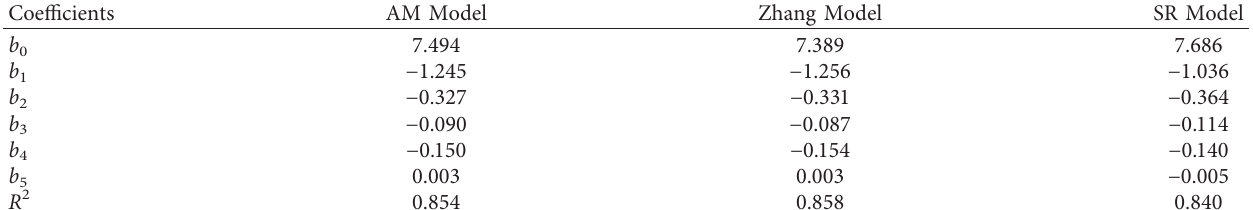
Table 13: Coefficients in the regression function f for the three